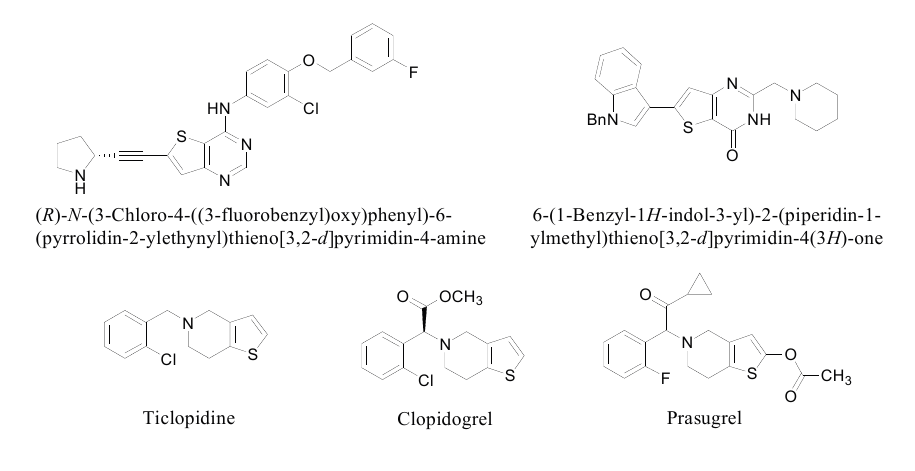
Figure 1. Bioactive thienopyrimidine and thienopyridine derivatives.